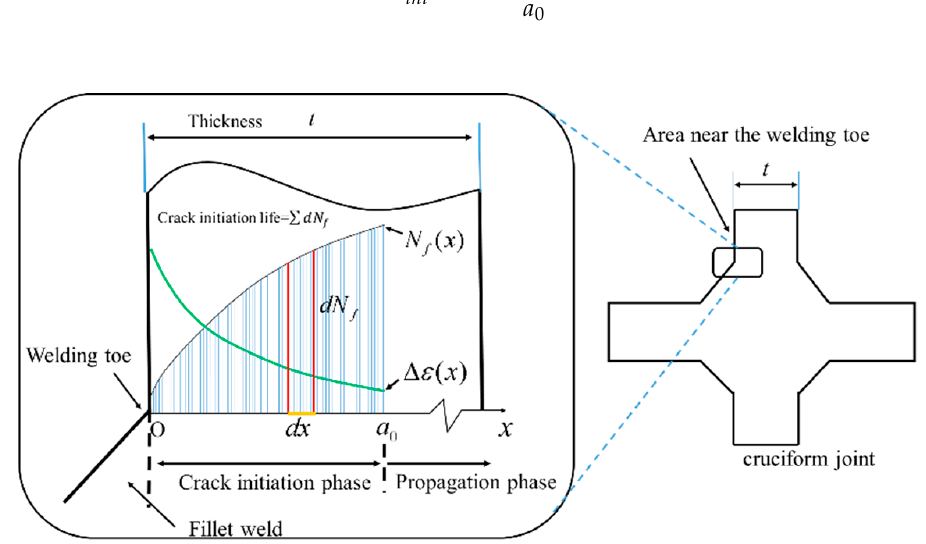
Figure 2. Calculation of weld toe crack initiation life of the cruciform joint.